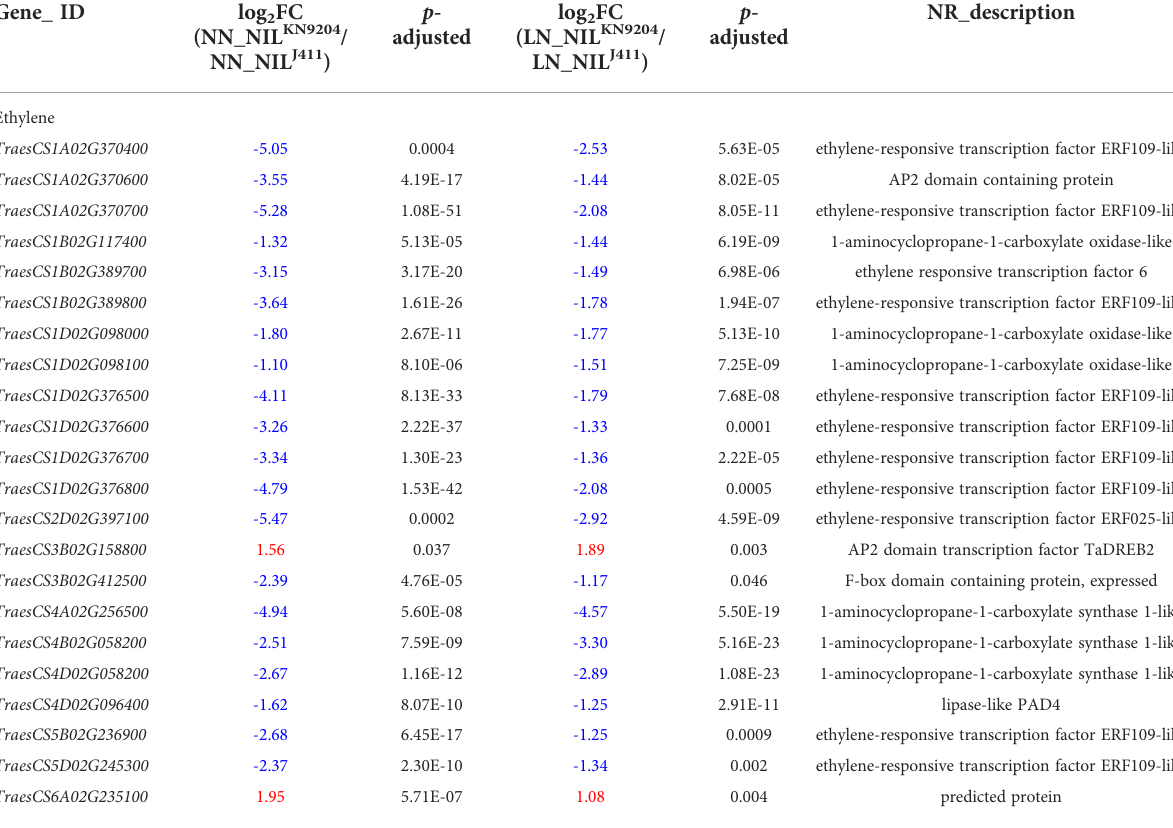
TABLE 4 DEGs involved in phytohormone metabolism and signaling between the pairwise